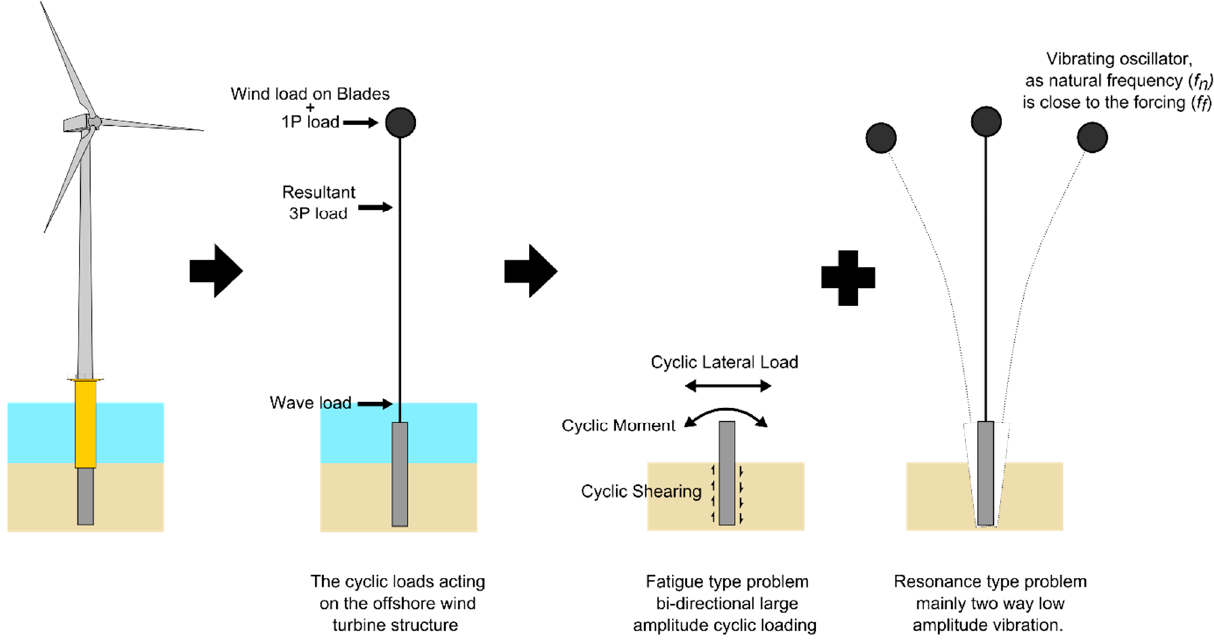
Figure 12. SSI mechanisms.